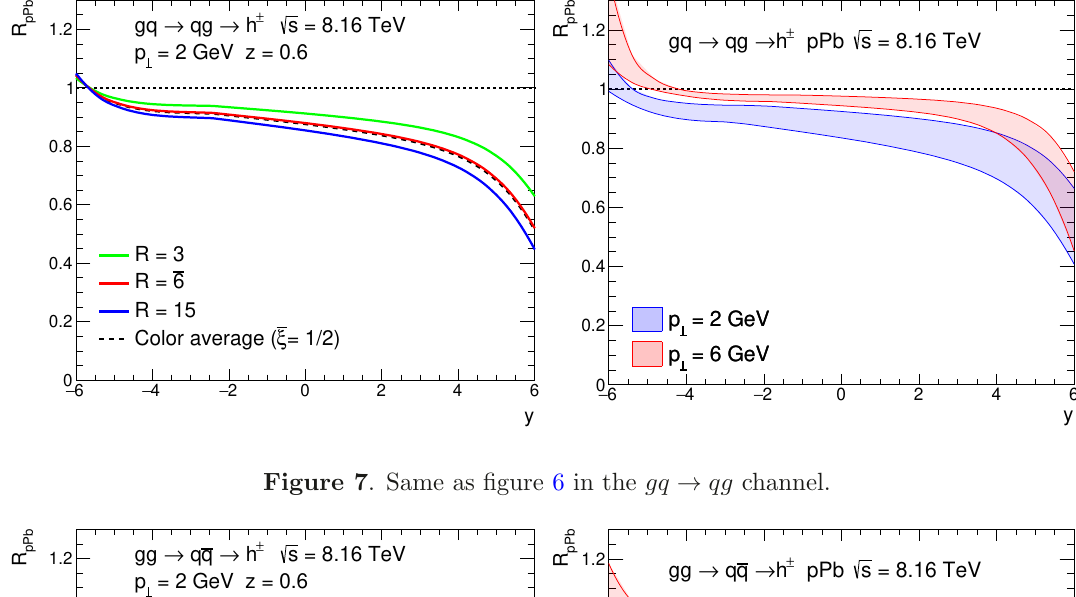
Figure 7 . Same as (cid:12)gure 6 in the gq